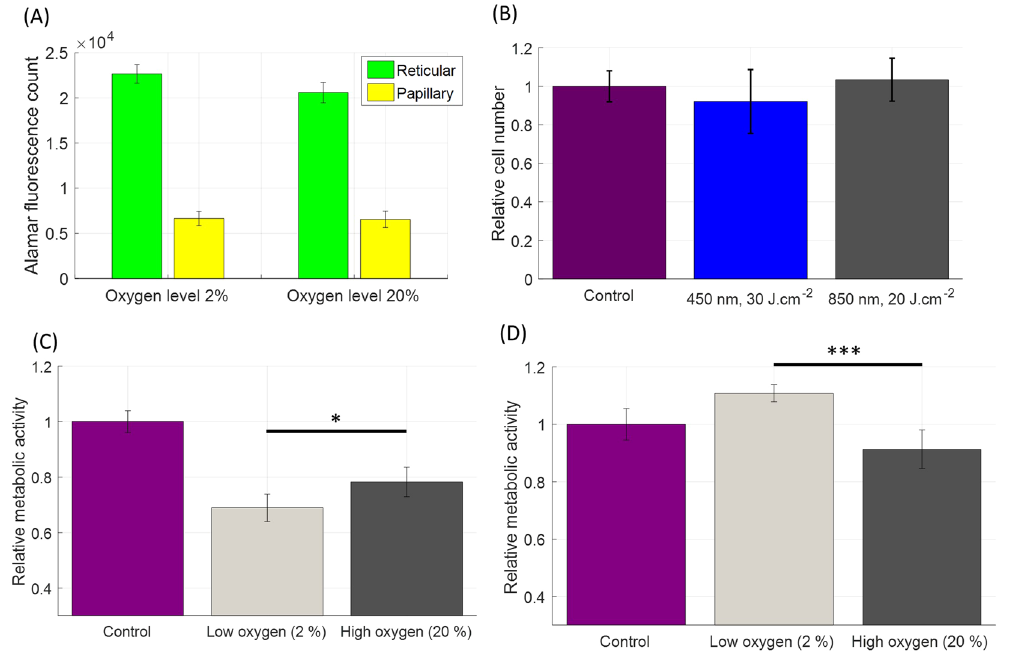
Figure 7. Impact of blue (450 nm) and NIR (850 nm) light treatment on the metabolic activity of human dermal fibroblasts when exposed to dermal tissue oxygen levels (approx. 2%). ( A ) Fluorescence counts (Alamar Blue) measured in reticular and papillary fibroblasts (facelift, female, 64 yo) in low (2%) and high (20%) oxygen levels. No strong change in Alamar fluorescence count is apparent. ( B ) Relative cell counts of human dermal fibroblasts (reticular and papillary) after light treatment in hypoxic conditions (2% oxygen). Cells were grown in 35-mm individual dishes and treated with light once a day for three consecutive days. Cell counting was performed 24 h after last treatment. Material originating from two different donors was included in the experiment (N = 2, reticular and papillary, 3 repeats, 12 counts per bar). ( C ) Relative metabolic activity of human papillary fibroblasts in response to 30 J.cm − 2 at 450 nm in low and high environmental oxygen levels (N = 2, papillary and 3 replicates). ( D ) Relative metabolic activity of human reticular fibroblasts in response to 20 J.cm − 2 at 850 nm in low and high environmental oxygen levels (N = 2, reticular and 3 replicates). Irradiance levels were 50 mW.cm − 2 (450 nm) and 80 mW.cm − 2 (850